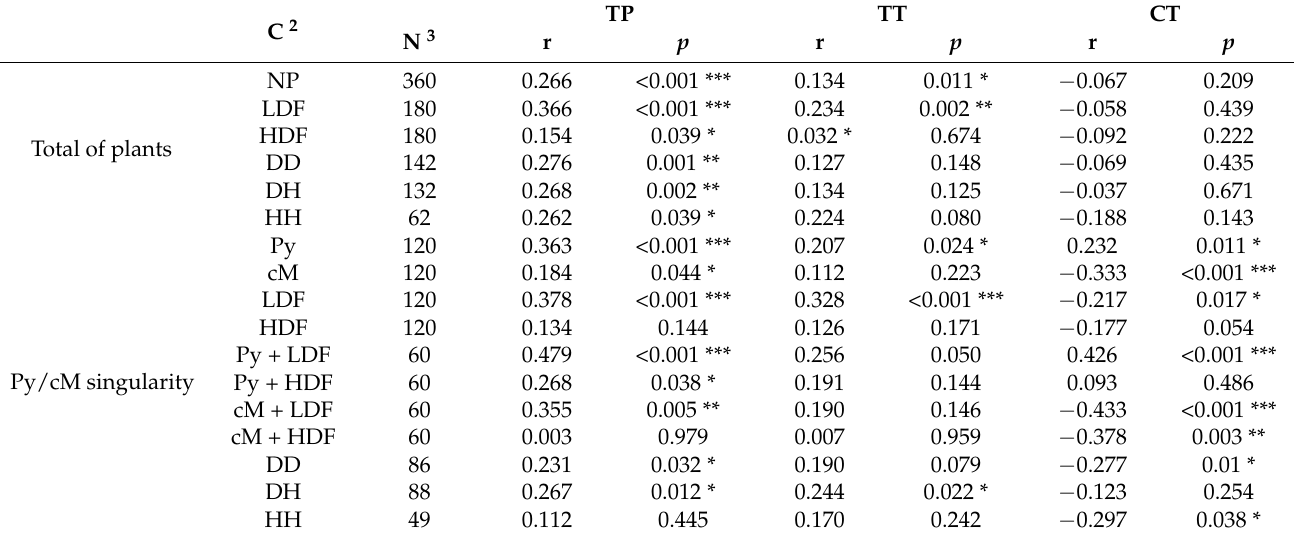
Table 5. Linear regression 1 between herbivory and defenses: effects of biogeographical, ecological, and genetic